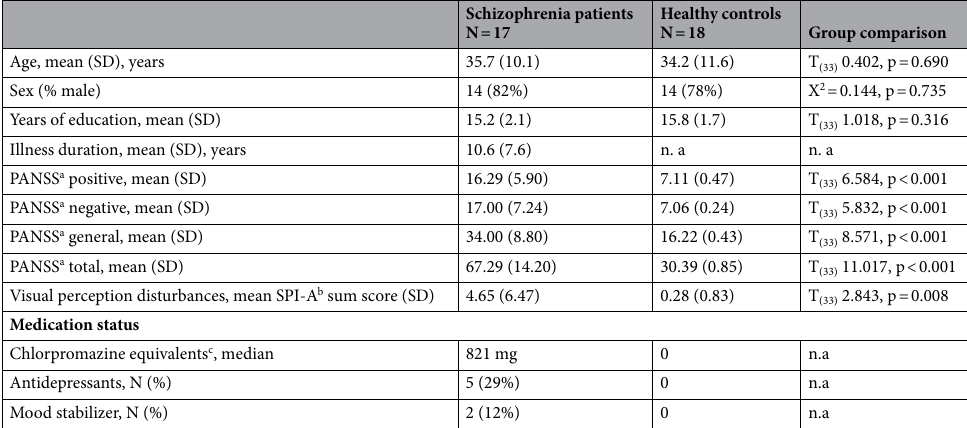
Table 1. Sociodemographic and clinical characteristics of patients with schizophrenia (N = 17) and healthy controls (N = 18) of similar age participating in a saccadic suppression task. a Positive and negative syndrome scale 44 . b Schizophrenia proneness instrument, adult version 45 . c According to Ref. 46 .